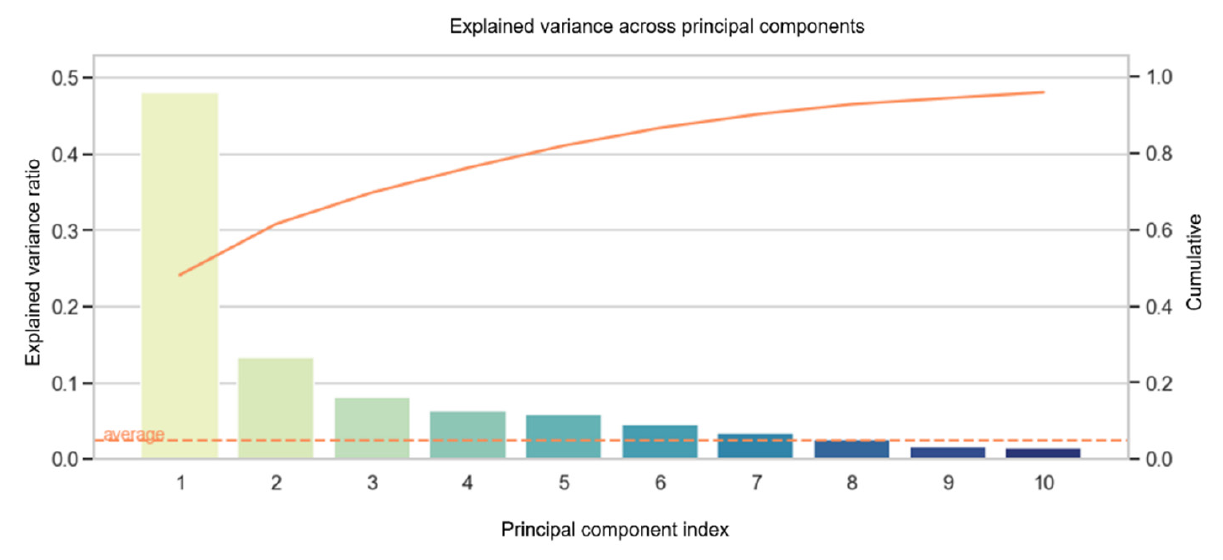
Figure 5. The explained variance of the 10 most valuable diagnostic features is given in descending order from left to right. The PCA bars each represent one component. For example, the first bar of the explained variance is composed of the following variables shown in Table 2. Solid line corresponds to the cumulatively explain of the data. LV-EF = left ventricular ejection fraction, RV-EF = right ventricular ejection fraction, RA = right atrial, LA = left atrial, RV = right ventricular. Table 2. Top ten highest rates for the first principal component.